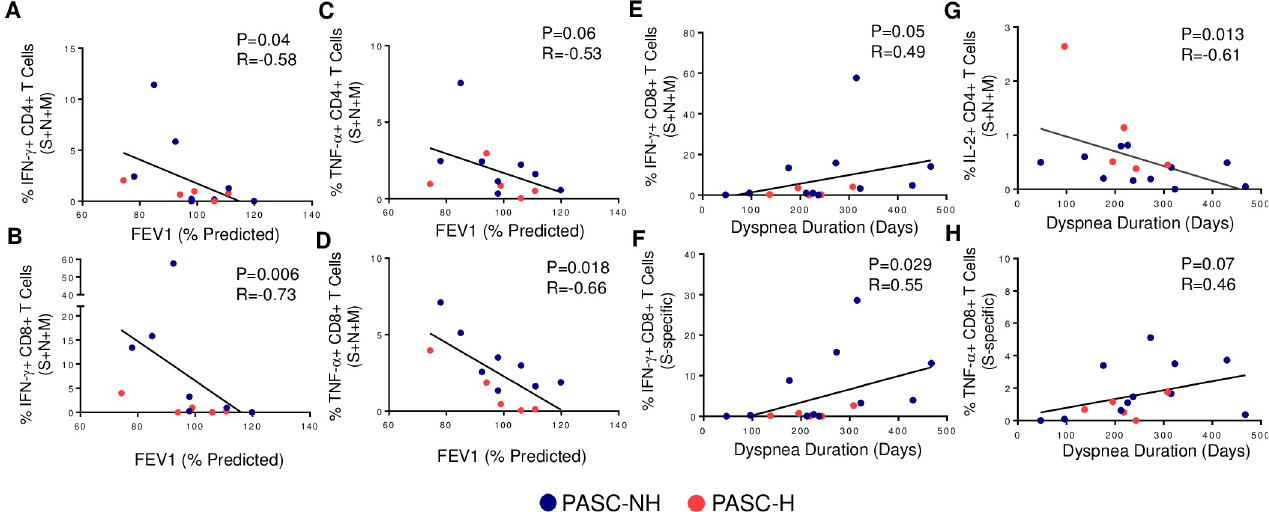
Fig 5. Correlations between SARS-CoV-2 specific T cells and FEV 1 and symptoms in PASC. Correlations between the percent predicted FEV 1 and the combined SARS-CoV-2 S-, N- and M-specific frequencies of IFN- γ -producing (A) CD4 + and (B) CD8 + T cells and TNF- α -producing (C) CD4 + and (D) CD8 + T cells are shown. Correlations of between the duration of dyspnea in days and the frequencies of (E) combined SARS-CoV-2 S-, N- and M-specific CD8 + T cells, (F) S-specific IFN- γ -producing CD8 + T cells, (G) combined S-, N- and M-specific IL-2-producing CD4 + T cells and (H) S-specific TNF- α -producing CD8 + T cells are shown. Each point represents data from one PASC participant. Blue and red symbols represent PASC-NH (not hospitalized) and PASC-Hospitalized participants, respectively. Spearman correlations were used to determine statistical significance.